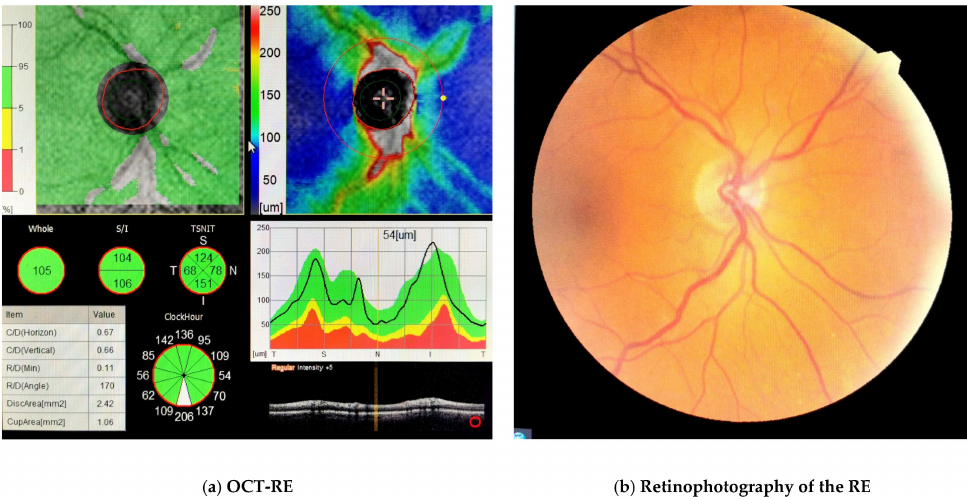
Figure 2. Optical coherence tomography (OCT) of the RE ( a ) showed no optic nerve damage and normal RNFL thickness. Additionally, fundus examination was normal in RE ( b ). The LE showed peripapillary atrophy of the optic nerve and a pigmented infero-nasal chorioretinal area. An